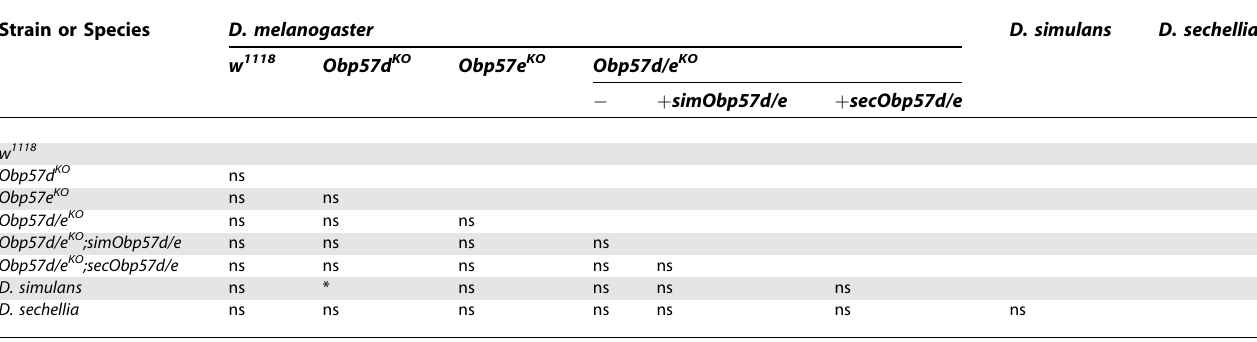
Table 1. Statistical Analysis of Results of Oviposition Site–Preference Assay (Acetic Acid) Strain or